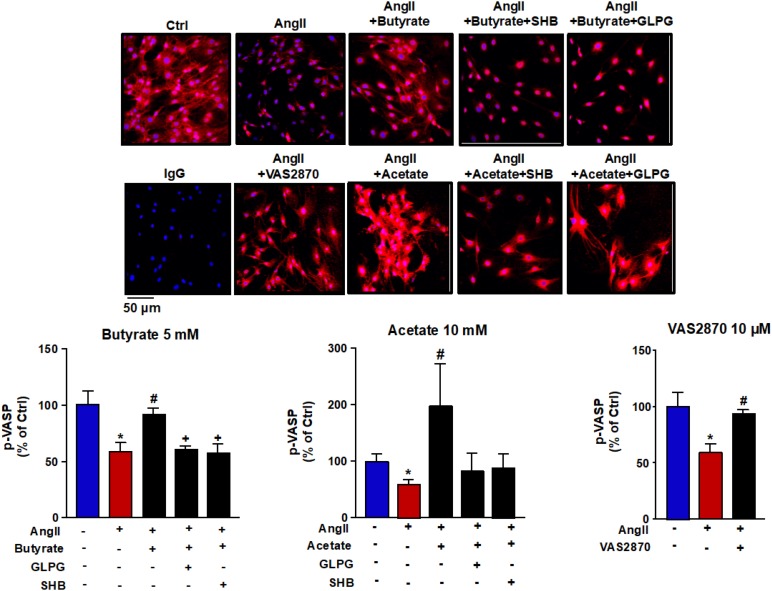
Effects of short-chain fatty acids (SFCAs) in VASP phosphorylation in rat aortic endothelial cells (RAECs). Pictures show VASP (Ser239) phosphorylation in RAECs incubated with butyrate (5 mM), acetate (10 mM), or propionate (10 mM). In some experiments, cells were coincubated with GLPG0974 (GLPG, 0.1 μM) or β-hydroxybutyrate (SHB, 5 mM) for 24 h, and in the last 6 h in the absence (Ctrl) or presence of angiotensin (Ang)II (1 μM), measured by immunostaining (red fluorescence) intensity normalized to the blue nuclear stain DAPI. Cells were stimulated by the calcium ionophore calimycin (A23187, 1 μM) for 30 min. Scale bar, 50 μm. Results are shown as mean ± SEM (four to six). *P < 0.05 vs. ctrl; #P < 0.05 vs. AngII; +P < 0.05 vs. AngII + SFCA group.